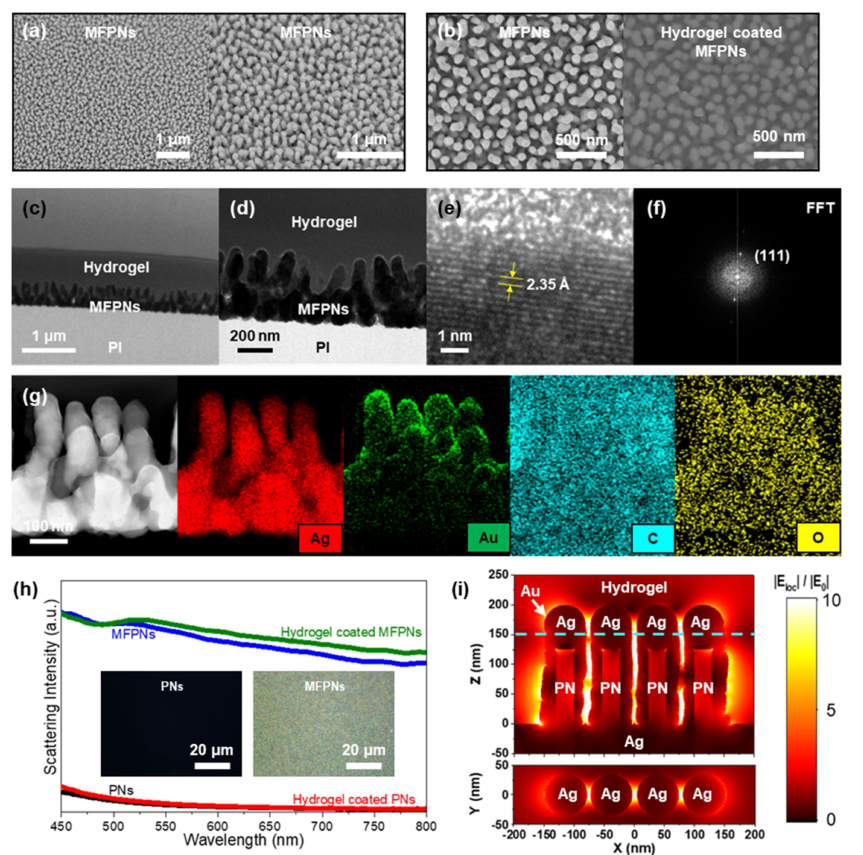
Figure 1. Morphological and crystalline analyses of the hydrogel coated metal film (Au/Ag) over polyimide (PI) nanopillars (PNs)(MFPNs). ( a , b ) FE-SEM images of the MFPNs without and with hydrogel encapsulation. Structural and crystalline properties of the hydrogel-coated MFPNs observed by ( c , d ) FE-TEM images, ( e ) HR-TEM image, and ( f ) the fast Fourier transform of the image in ( e ). ( g ) Compositional analysis with elemental mapping of Ag, Au, C, and O in the hydrogel-coated MFPNs. ( h ) Scattering intensity of the nonplasmonic PNs and plasmonic MFPNs with and without the hydrogel skin. The photograph of ( h ) demonstrates the true color of scattered light. ( i ) Numerically calculated E -field profiles of the hydrogel-coated